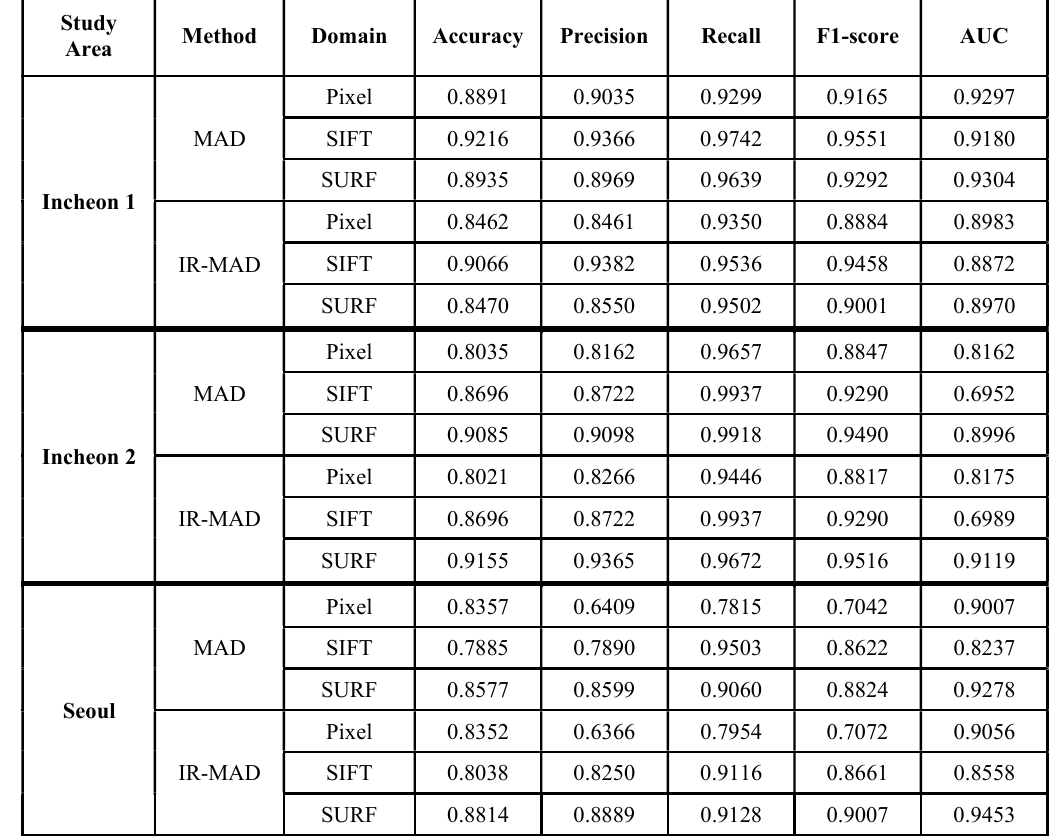
Table 2. Performance Result of pixel-based and feature-based change